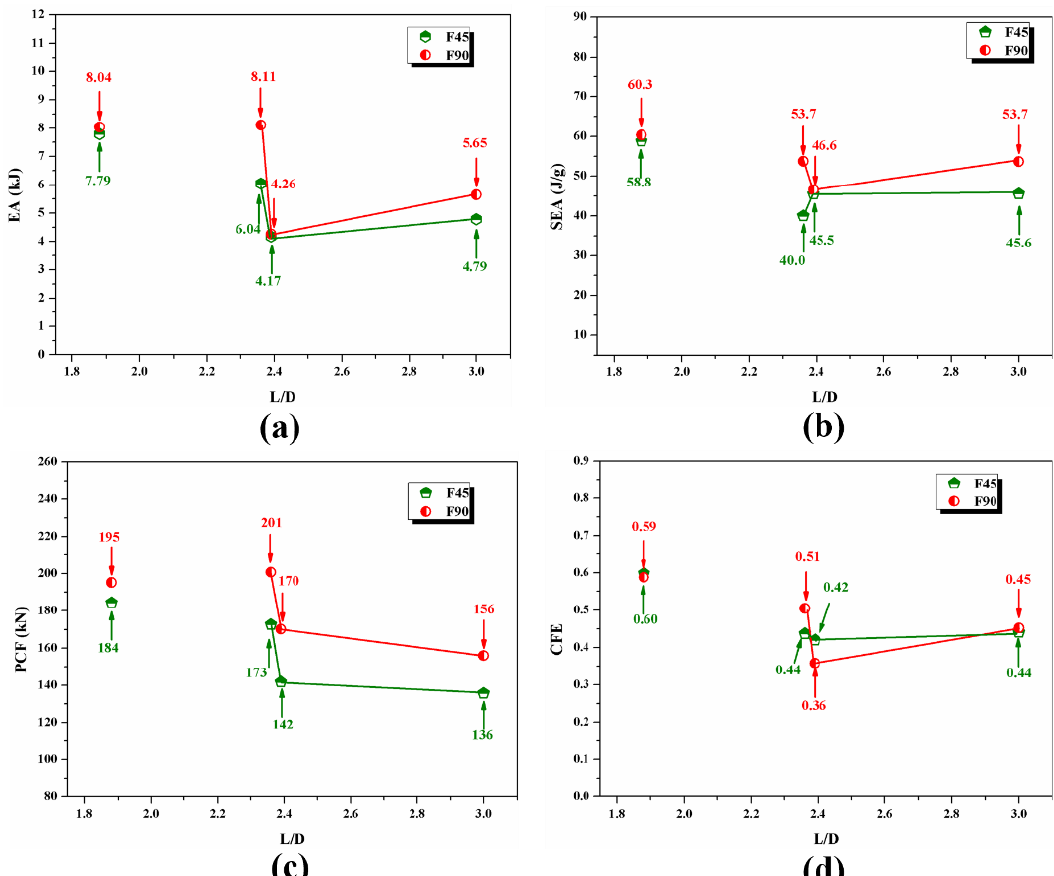
Figure 15. Effects of geometric size on the energy-absorption performance of 2/1 hybrid tube: ( a ) EA ; ( b ) SEA ; ( c ) PCF ; ( d ) CFE .